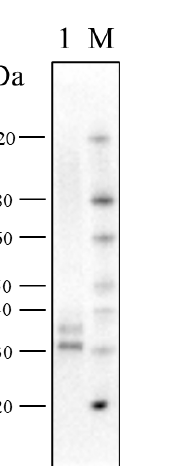
Figure 3. Western blot and SDS-PAGE analysis for SC-lasB and PA-lasB after protein purification. ( A ) Lane M: WB Protein Standard (M00521, Genscript). Lane 1 refers to the protein bands binding by the His-tag antibody from the fermentation supernatant of B_lasB2 strain. ( B ) Lane M: Protein Ladder (P0063, Beyotime). Lane 1: the fermentation supernatant of B_lasB2. Lane 2: the purified SC- lasB from B_lasB2. ( C ) Lane M: Protein Ladder (P0063, Beyotime). Lane 1: the fermentation super-